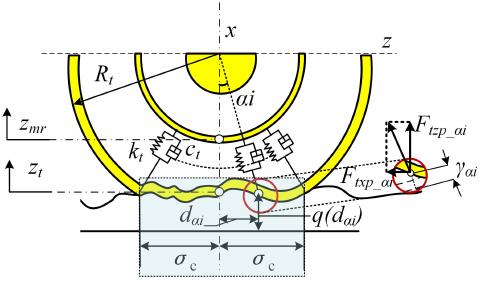
Figure 6. The illustrative representation of the